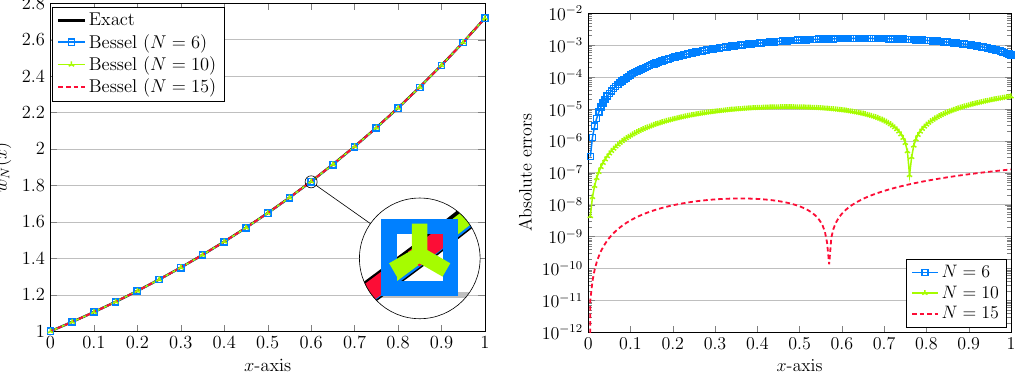
Figure 2. Graphs of the exact and computed solutions utilizing N = 6,10,15 ( left ) and the resulting absolute errors ( right ) for (cid:96) = 1 in Example 2. Table 2. The comparison of absolute errors in the Bessel matrix approach in Example 2 utilizing [ 0, (cid:96) ] . N = 10,20,30, (cid:96) = 1,2,5, and diverse x ∈ Bessel